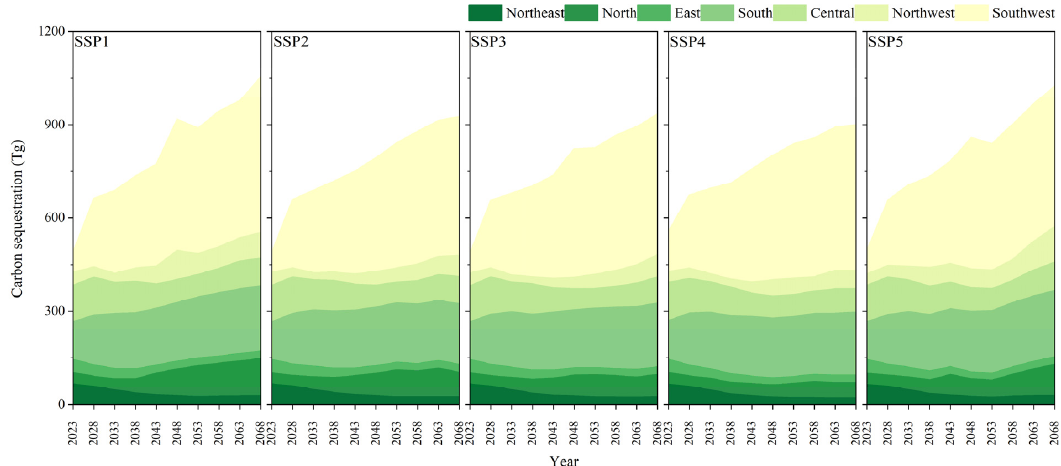
Figure A2. Regional projected carbon sequestration by SSPs in ten five-year rotation periods.